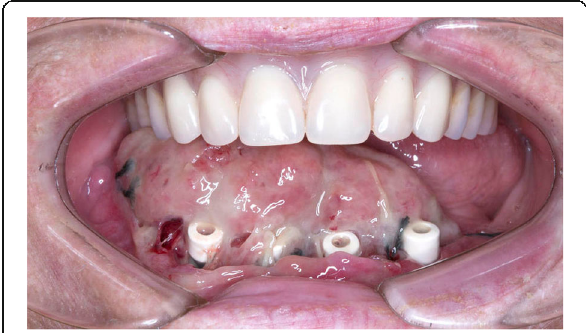
Fig. 2 After implant exposure, placement of healing abutments and soft tissue surgery around the dental implants (all done simultaneously). Extensive gingival enlargement of the floor of mouth and lingual gingival tissue